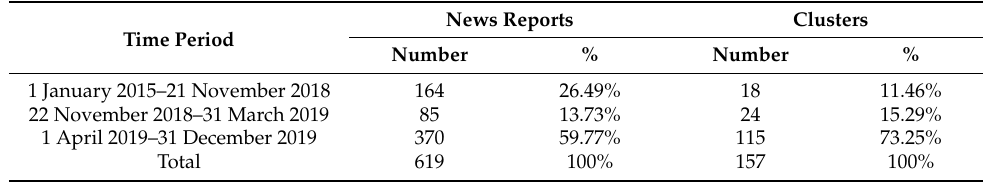
Table 2. Number of news reports and clusters identified between 2015–2019.